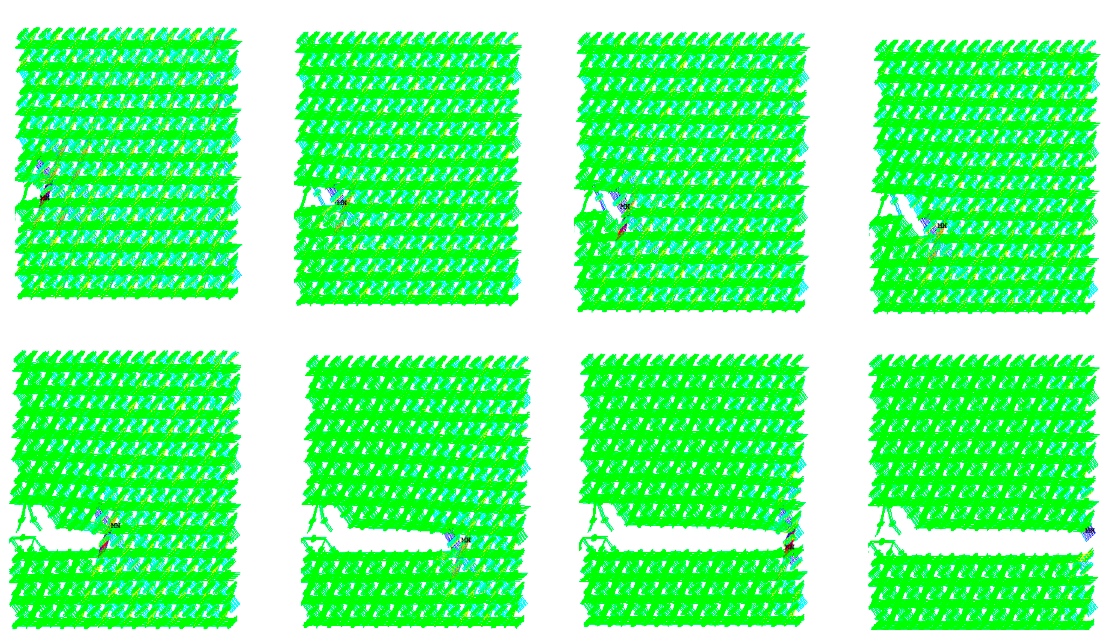
Figure 13. Damage evolution process of materials of two different arrangement forms of cemented particulate composite.